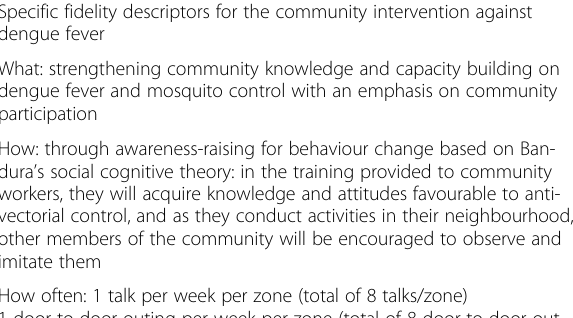
Table 2 Specific descriptors of the